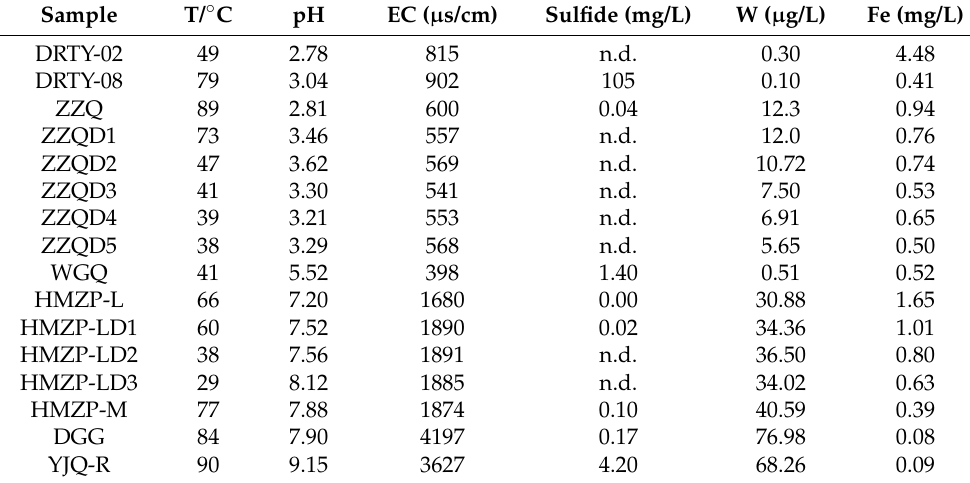
Table 1. In situ parameters and the concentrations of Fe and W in the Rehai hot springs. The data